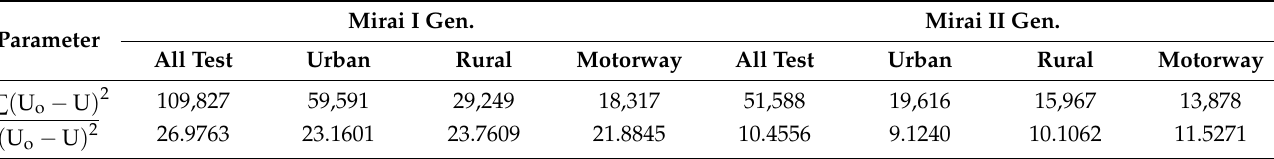
Table 5. Conditions for ending the search for the minimum of the objective function (Equation (9)). Mirai I